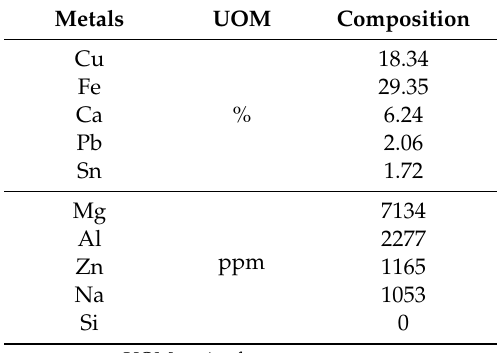
Table 1. Chemical compositions of the copper sludge